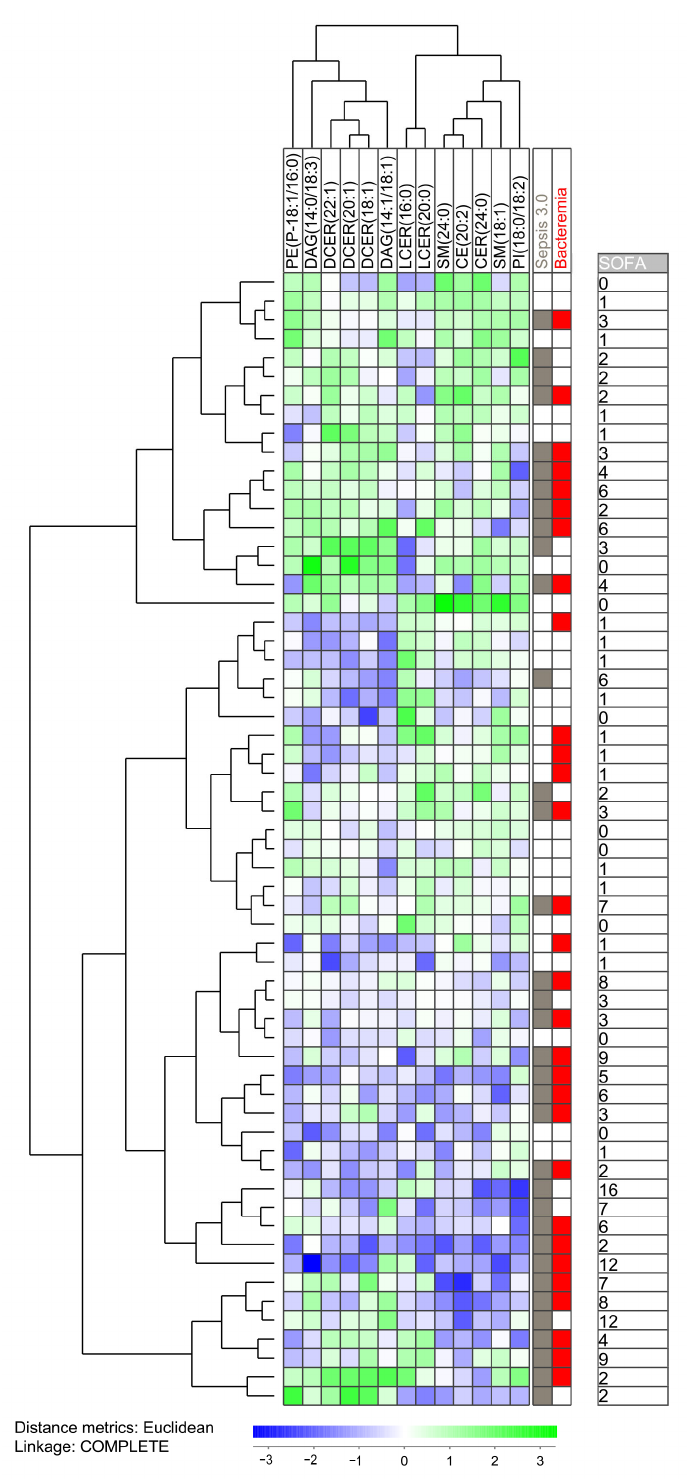
Figure 1. Subclassification of sepsis patients based on the 13 metabolites (mainly sphingolipids) that differed significantly when comparing patients fulfilling the Sepsis-3 criteria versus patients that only fulfilled the Sepsis-2 criteria. The analysis was based on the 13 metabolites (i) showing detectable levels for at least 10 patients and (ii) showing a statistically significant difference when comparing the two patient subsets. All 60 patients were included in the analysis. The characteristics of each individual patient (organ failure, bacteremia, total SOFA score) is indicated to the right in the figure.